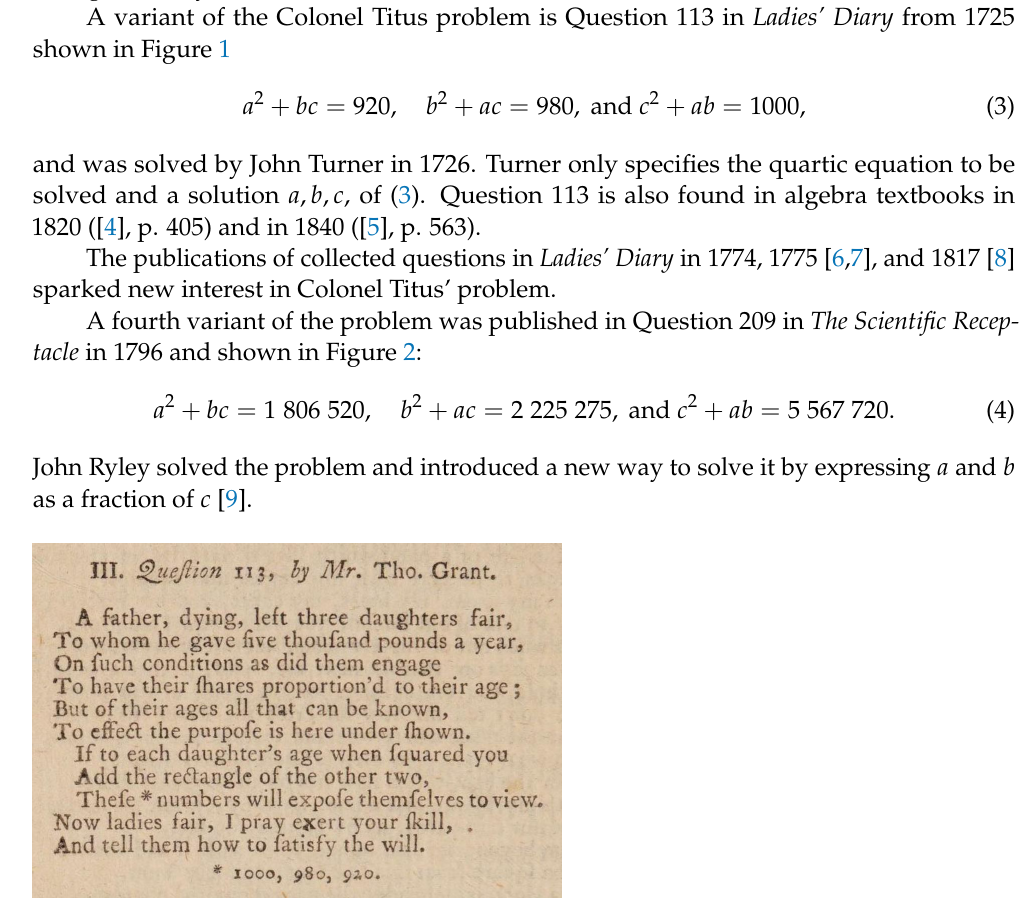
Figure 1. Question 113, proposed by Thomas Grant in Ladies Diary from 1725, taken from Charles Hutton 1775 [7], p. 266. In the collection by Leybourn from 1817, the question is slightly rephrased [8], p.